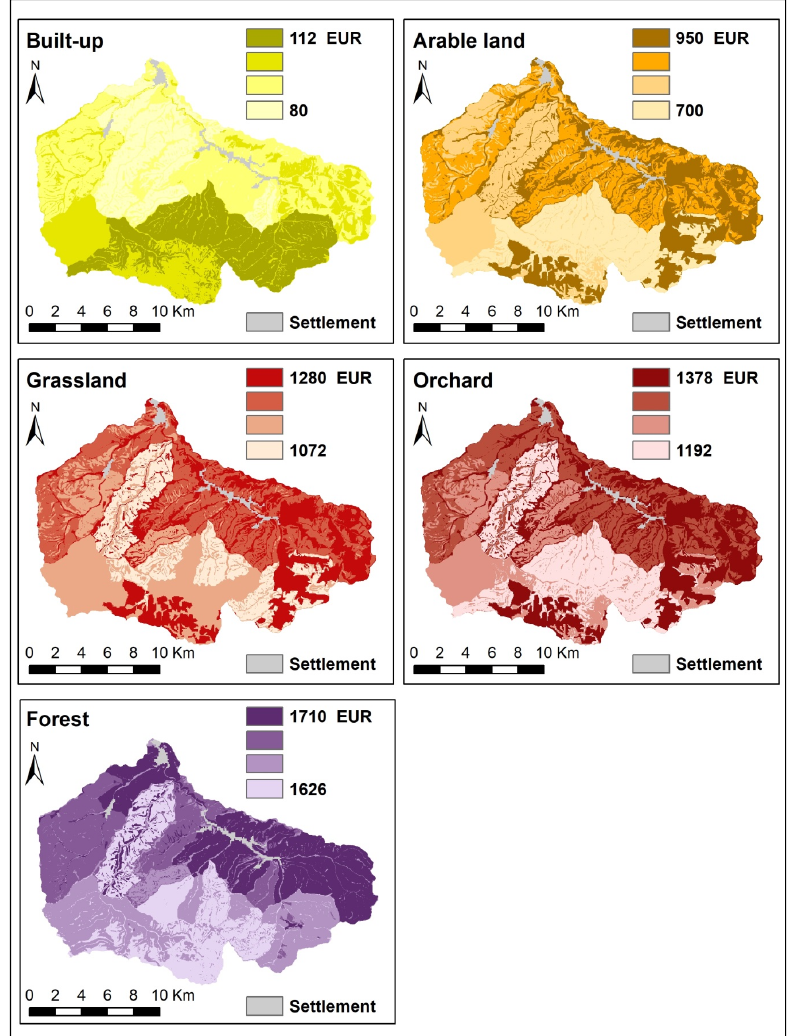
Figure 6. Monetary valuation of flood protection ecosystem service of different ecosystems (land use types).